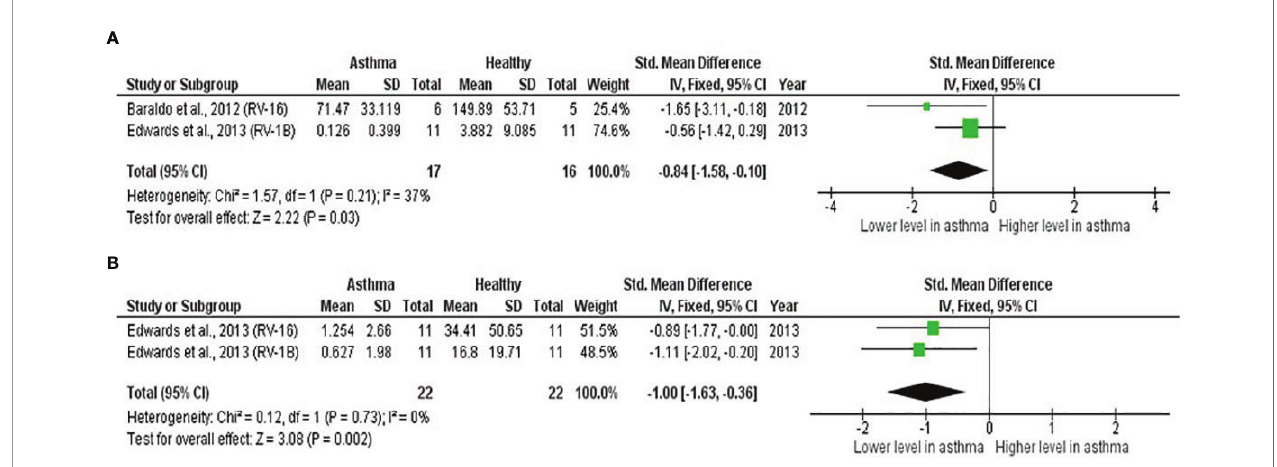
FIGURE 3 | Forest plots of (A) IFN- b and (B) IFN- l for ex vivo PBECs studies comparing children with atopic asthma vs non-atopic healthy controls. PBECs from children with atopic asthma produced signi fi cantly lower levels of (A) IFN- b (ES: -0.84, p = 0.030) and (B) IFN- l (ES: -1.00, p = 0.002) compared to non-atopic healthy children after RV